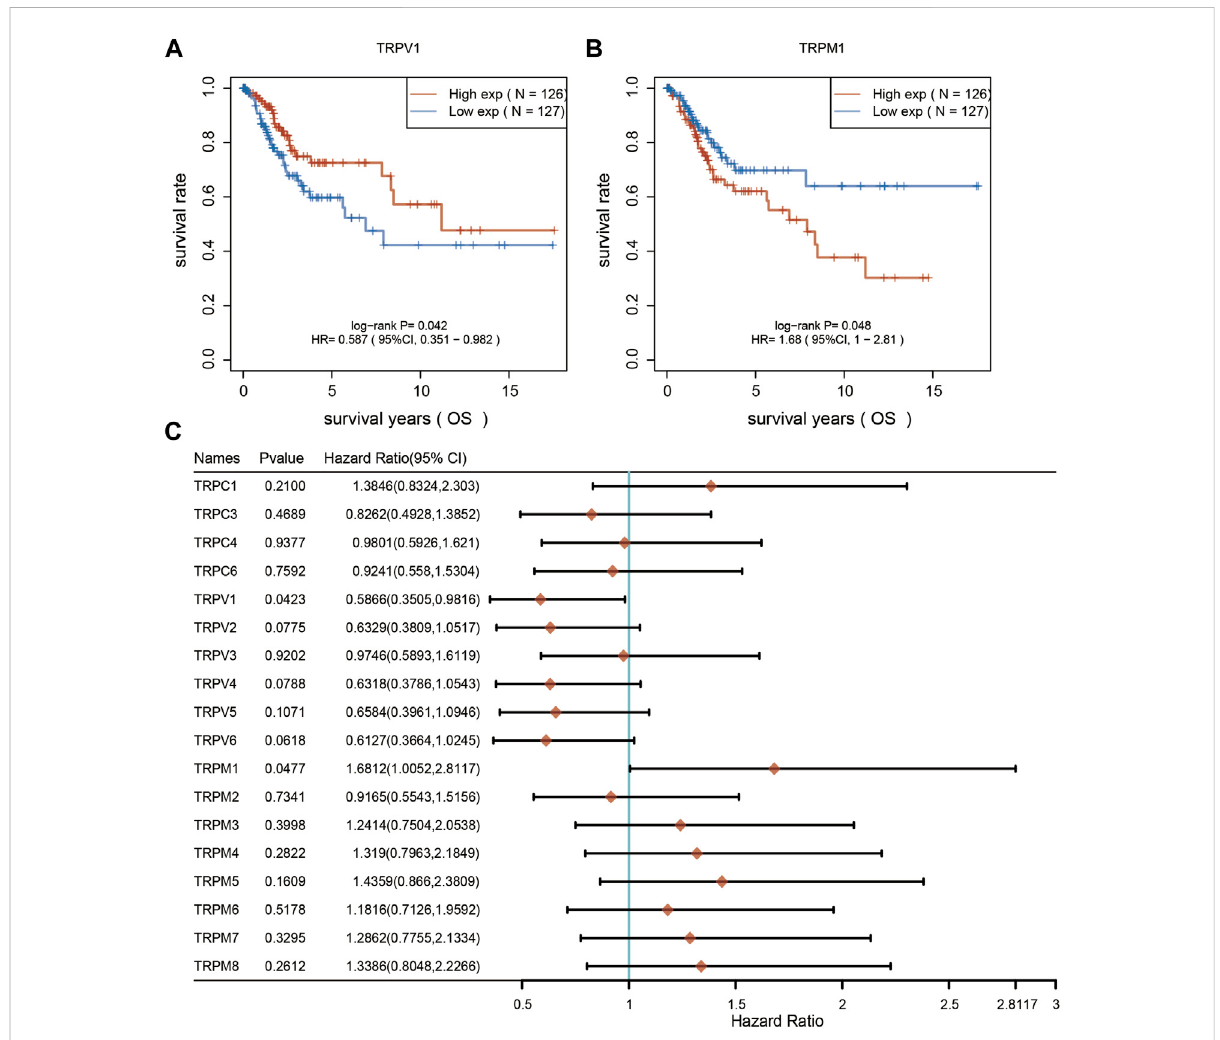
Overall survival curves were used to evaluate the prognosis of CSCC patients. (A,B) From left to right, overall survival analysis based on TRPV1 and TRPM1 expression. (C) Overall survival curves of TRPs were analyzed in CSCC